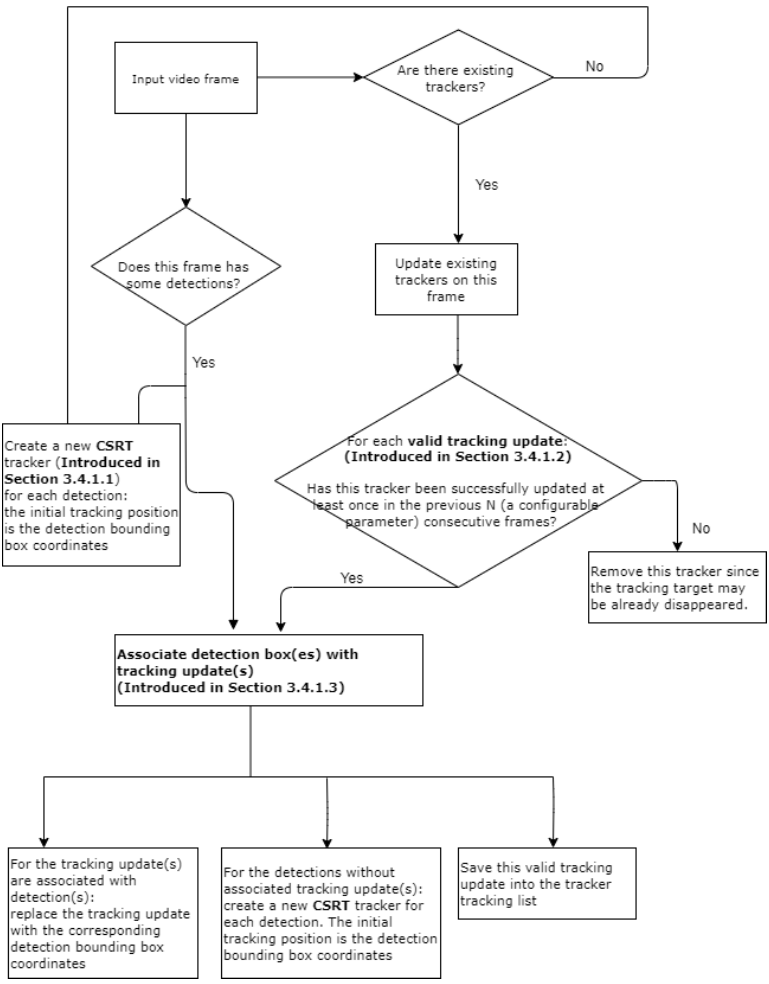
Figure 3. Process of object